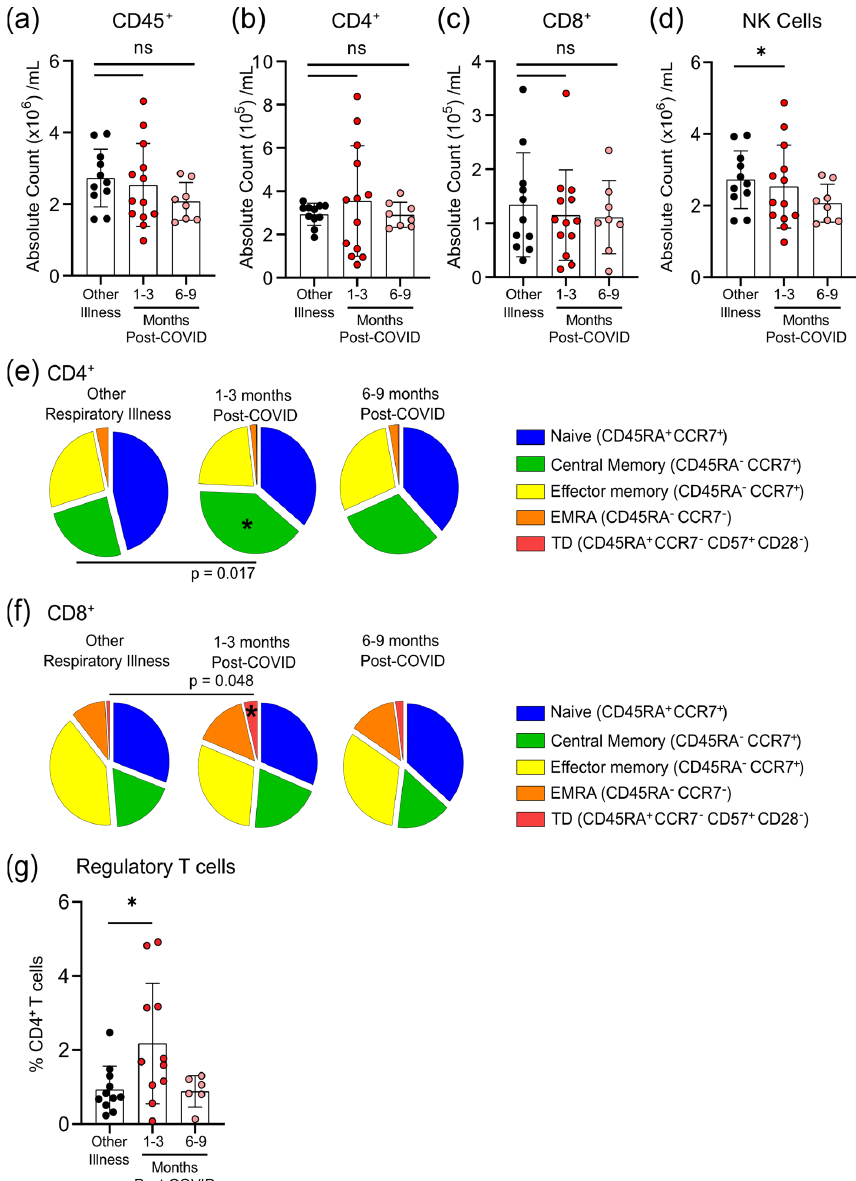
Figure 4. Transient changes in circulating lymphocytes occur 1–3 months after COVID-19 infection. Absolute numbers of circulating CD45 + T-cells ( a ), CD4 + T-cells ( b ), and CD8 + T-cells ( c ) were not different after 1–3 months or 6–9 months post-symptom presentation in seropositive individuals recovered from mild COVID-19 infection, compared to seronegative individuals recovered from other respiratory infections; however, NK cell numbers ( d ) were lower in the 1–3 months post- COVID-19 infection group. At 1–3 months post recovery from COVID-19 there was an increase in